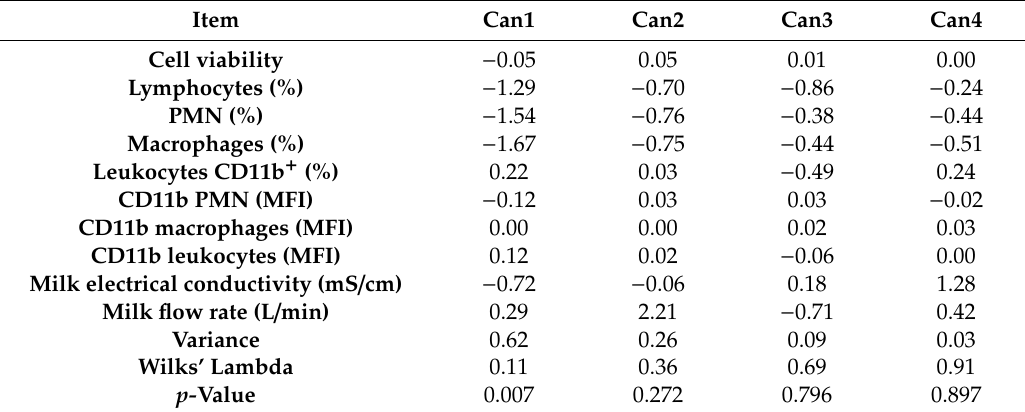
Table 4. Linear discriminant analyses and weights of the original variable on the canonical variates.